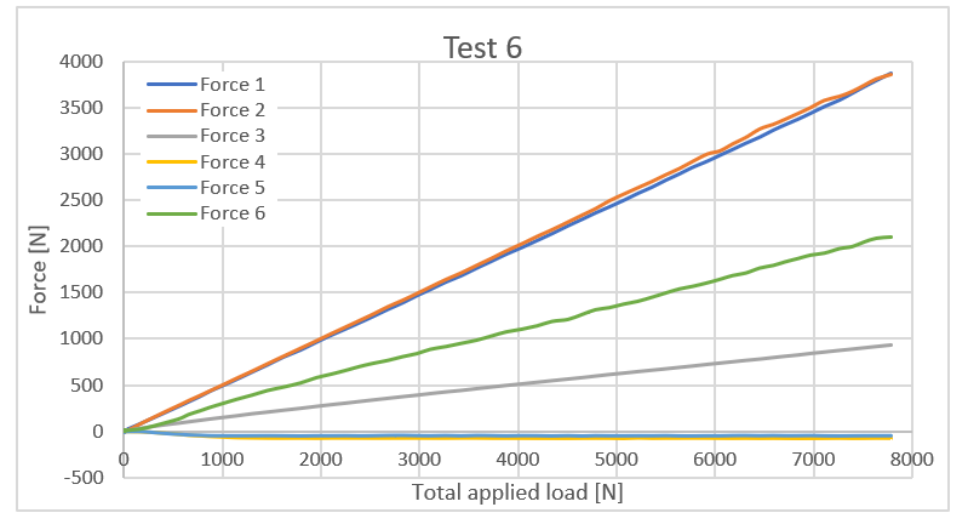
Figure 16. Total force redistribution into individual load cells during test six.